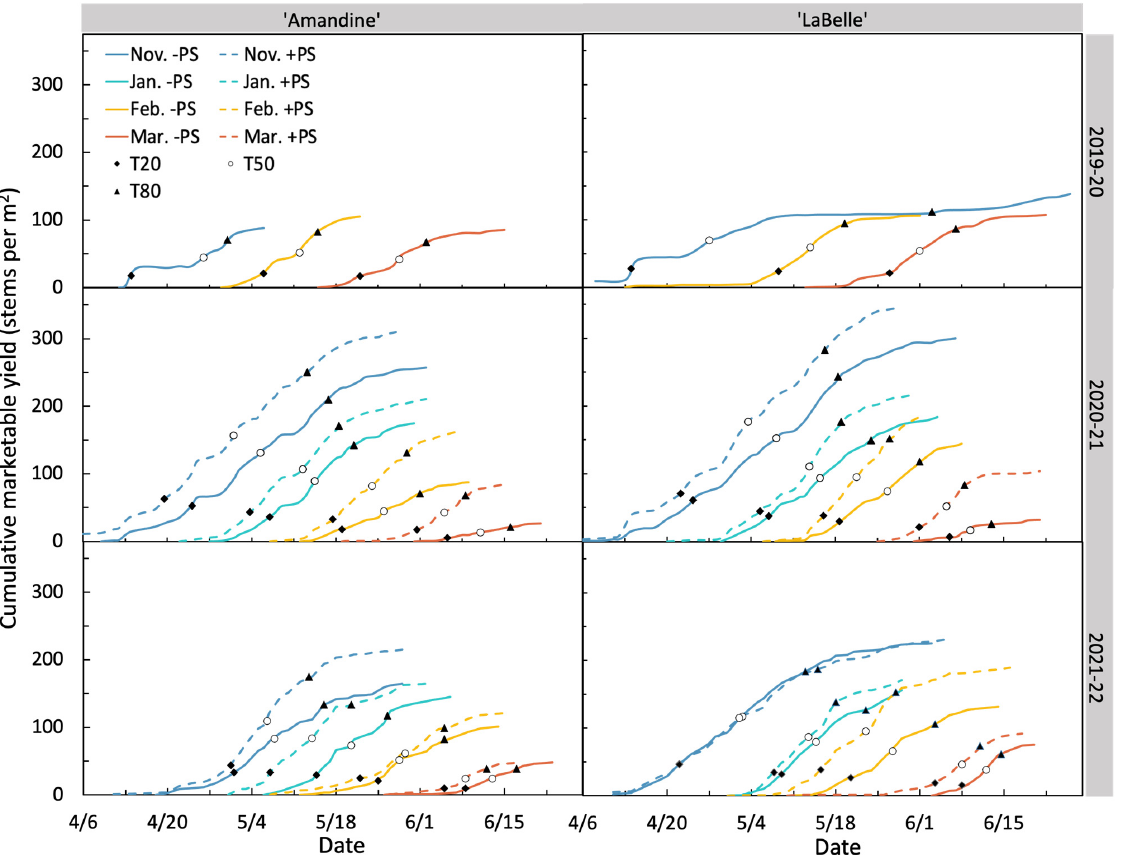
Figure 4. Cumulative marketable high tunnel yield of ‘Amandine’ ( left ) and ‘LaBelle’ ( right ) ranun- culus in 2019–20 ( top ), 2020–21 ( middle ), and 2021–22 ( bottom ) in North Logan, UT by planting date (Nov.—blue; Jan.—aqua; Feb.—yellow; Mar.—red) that were pre-sprouted (+PS; dashed) or not pre-sprouted (-PS; solid). T20 (diamonds), T50 (circles), and T80 (triangles) mark the completion of 20, 50, and 80% of marketable yield, respectively.